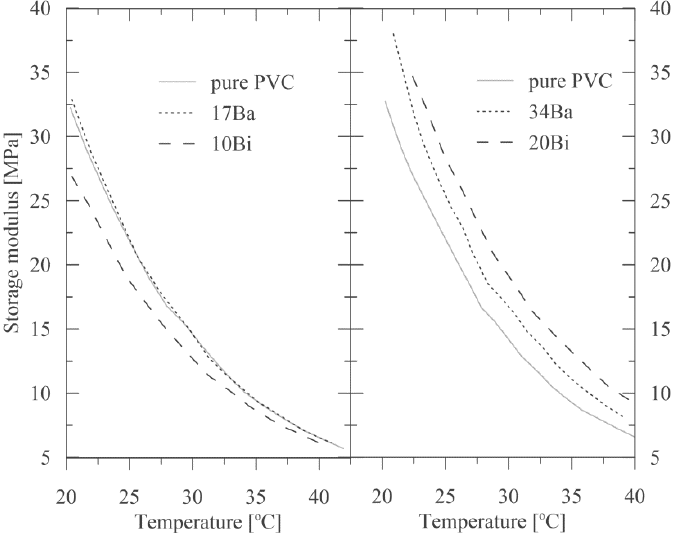
Figure 7. The storage modulus of the samples as a function of temperature (the semi-log coordinates).